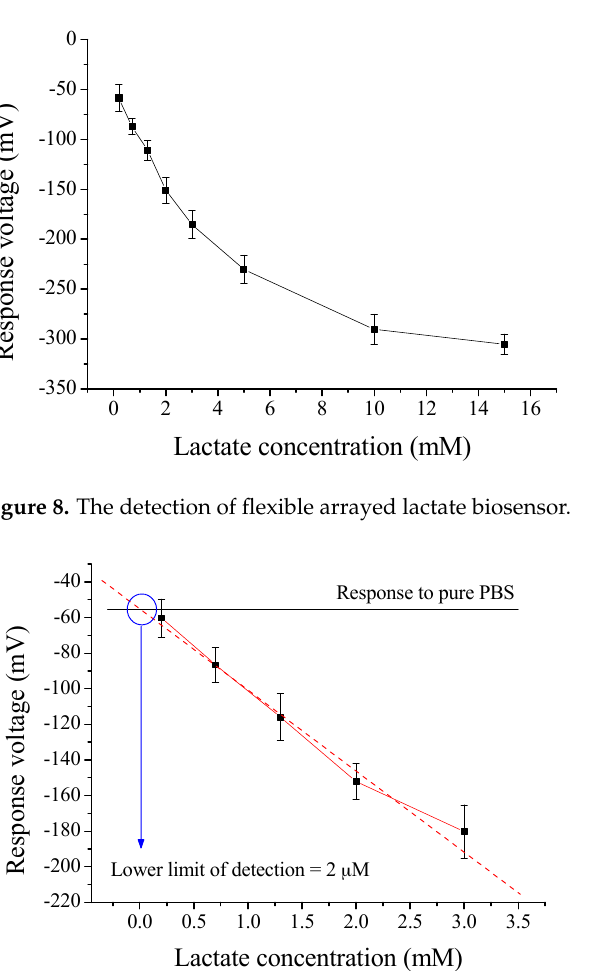
Figure 9. The lower limit of detection of flexible arrayed lactate biosensor. PBS: phosphate buffer solution.